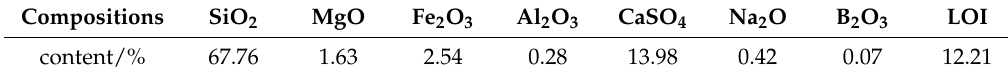
Table 2. Main chemical composition of acid leaching residue (wt %).